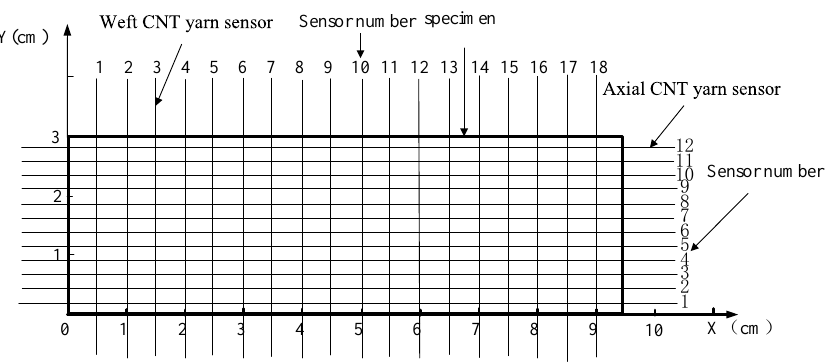
Figure 6. Numbering method of sensor embedded in braided composites.